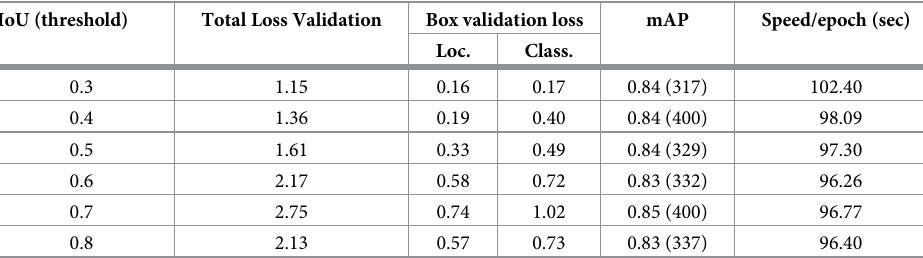
Total loss for validation, box-validation loss for localization (Loc.) and classification (Class.), best mAP before 400 steps, and training time for one epoch in seconds using various IoU thresholds (ranging from 0.3 to 0.8). The change in the IoU threshold, although it did not lead to significant changes in mAP, led to the best performance with a value of 0.7.